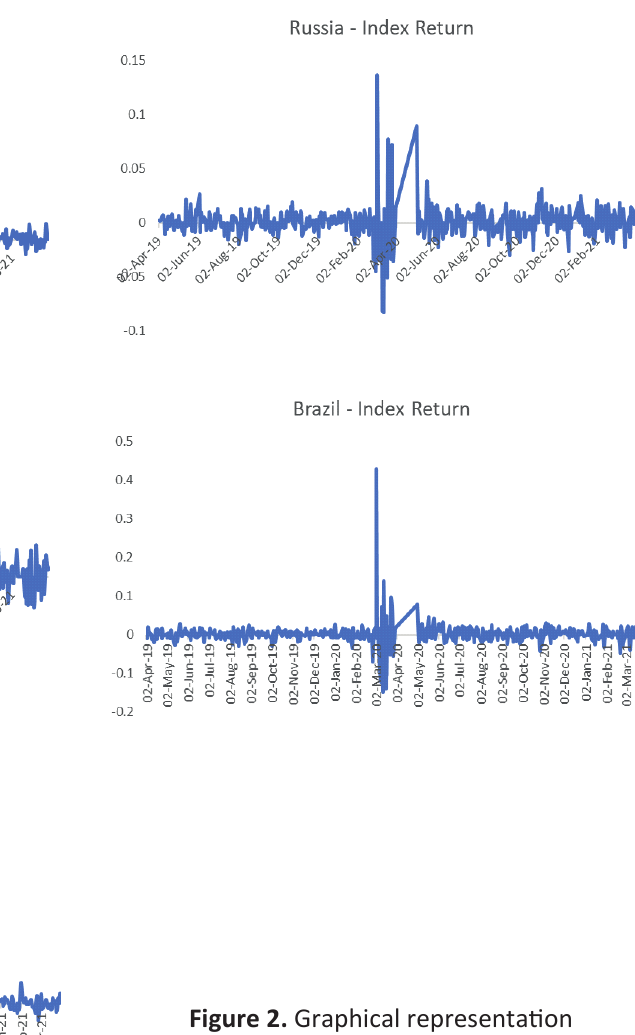
Figure 2. Graphical representation of return of indices of BRICS